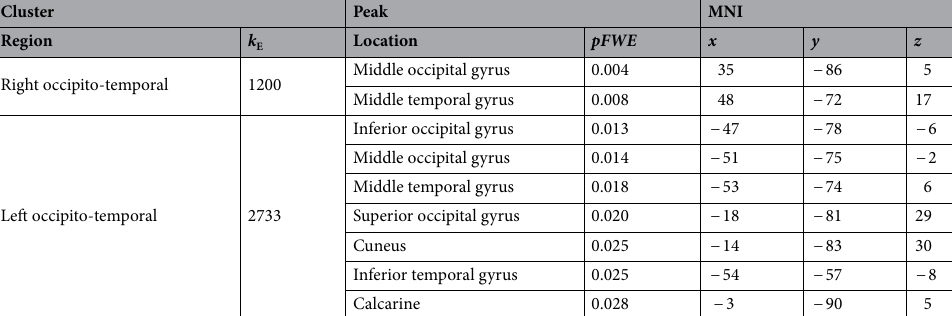
Table 1. Brain regions showing significant positive correlation with tilt-dependent error (TE) values in the SVBA task in the thresholding-free cluster enhancement (TFCE) analysis. Results are listed at p < 0.05 FWE-TFCE-corrected. The extent of each cluster was calculated based on the TFCE p value image using the xjview toolbox (http:// www. alive learn. net/ xjview). k E cluster size, pFWE p value FWE-TFCE-corrected, MNI Montreal Neurological